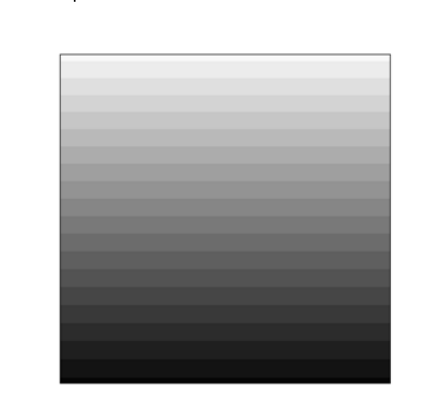
Fig. 2. The temperature field.